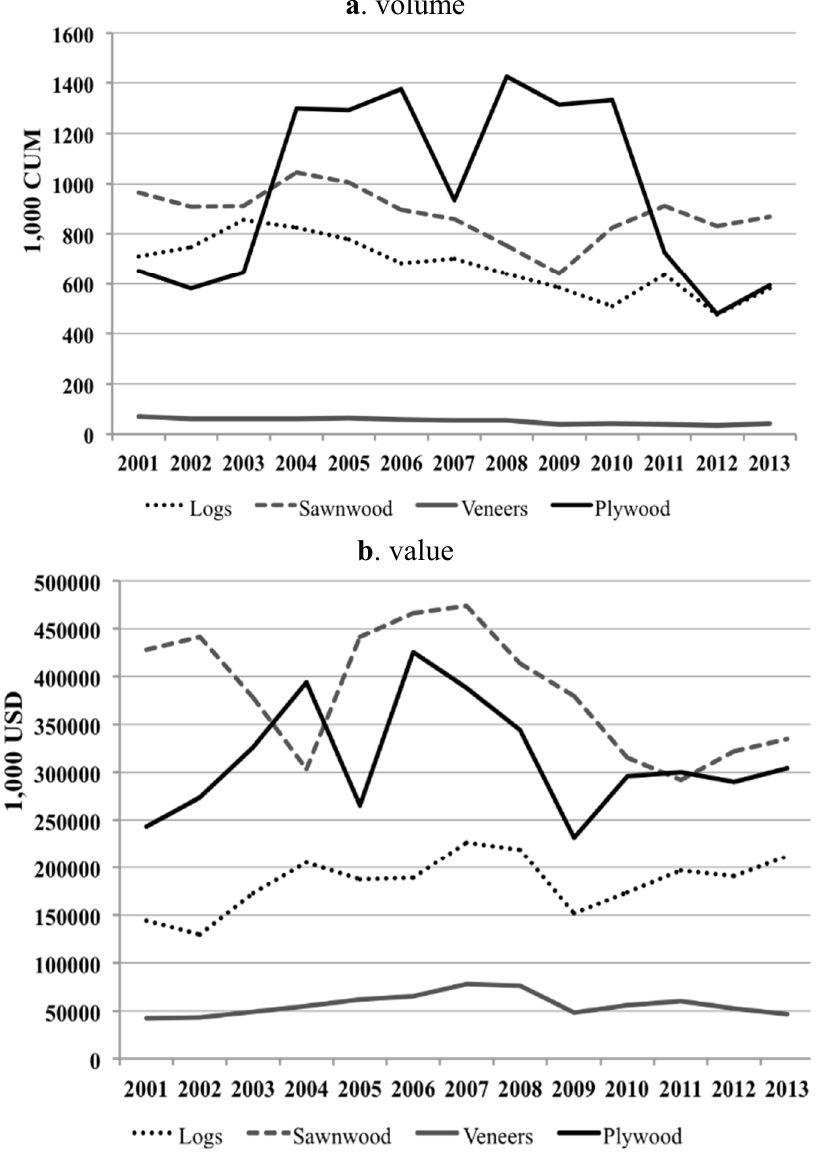
Figure 1. International tropical timber trade—in volume ( a ) and value ( b )—for selected product groups (2001–2013). Source: own elaboration from